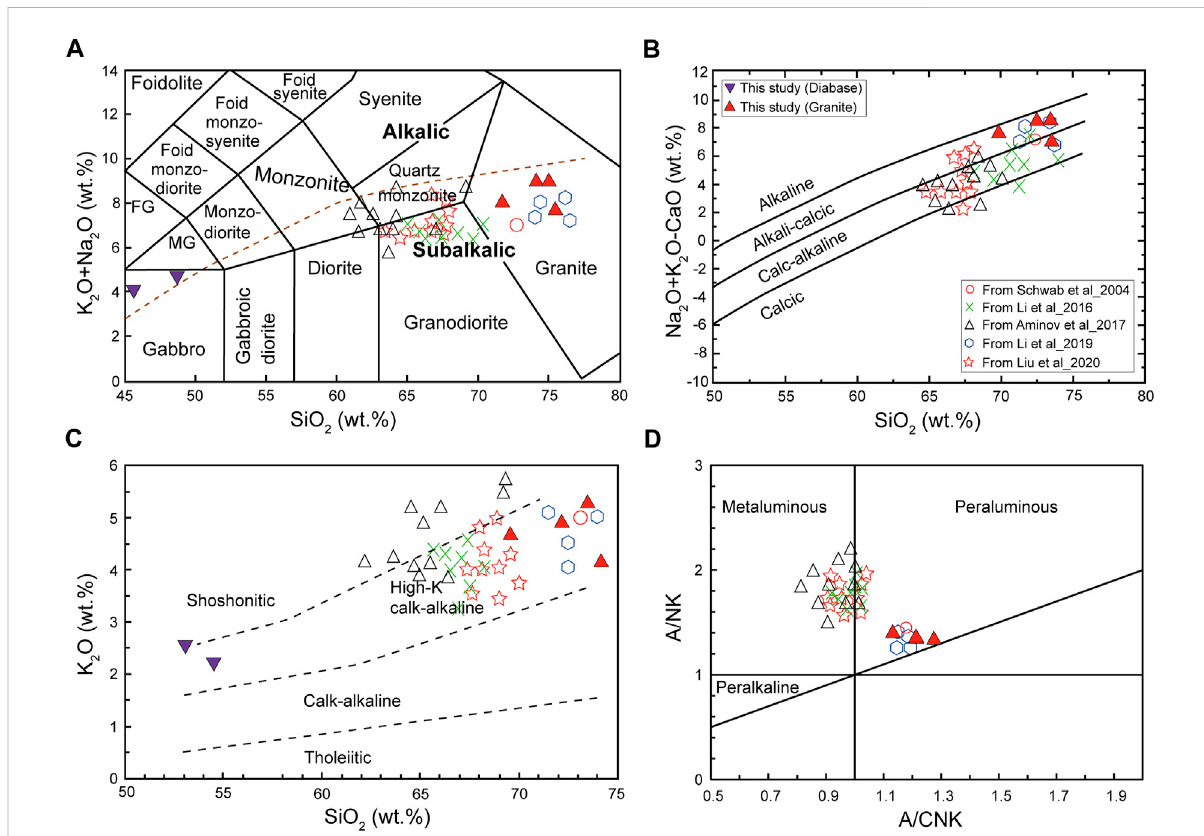
FIGURE 5 (A) K 2 O+Na 2 O vs. SiO 2 (after Le Bas etal. (1986)); (B) SiO 2 vs. Na 2 O+K 2 O-CaO (Frost etal., 2001); (C) SiO 2 vs. K 2 Oreferenced from Roberts and Clemens (1993); (D) A/NK versus A/CNK (after Maniar and Piccoli (1989)). Diagrams of igneous rocks from Kara Djilga-2 valley, Pshart complex, and other published Cretaceous plutons from